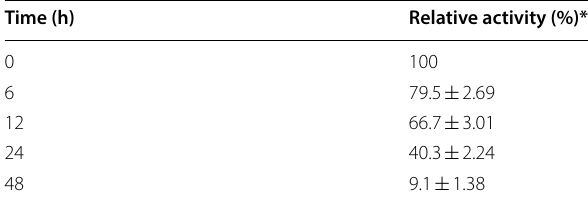
* Values represent mean